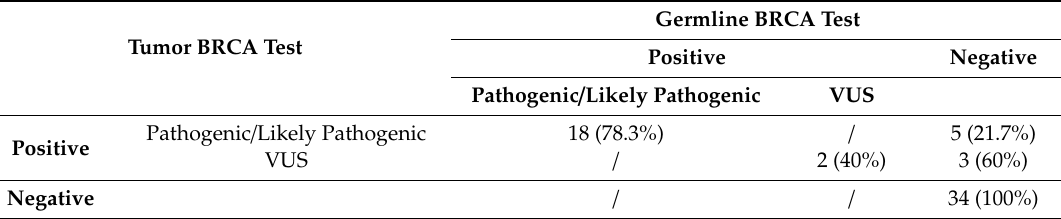
Table 3. Correlations between tumor and germline BRCA1 / 2 status ( n =